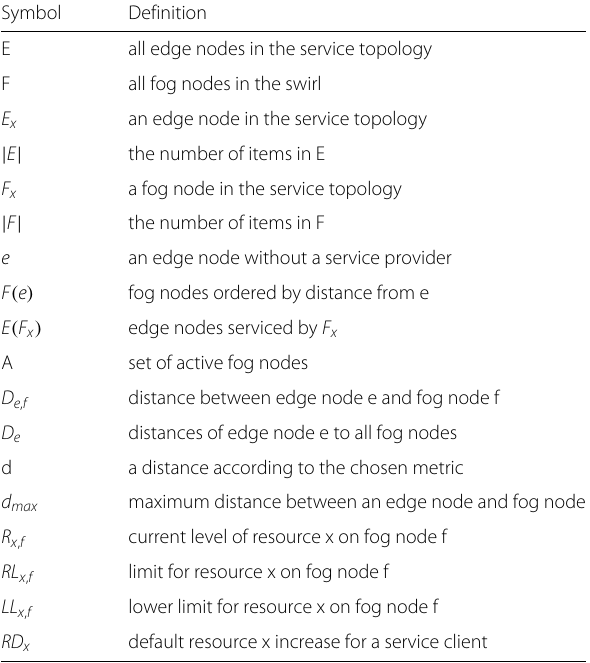
Table 1 Definitions of symbols used in algorithms 1, 2 and